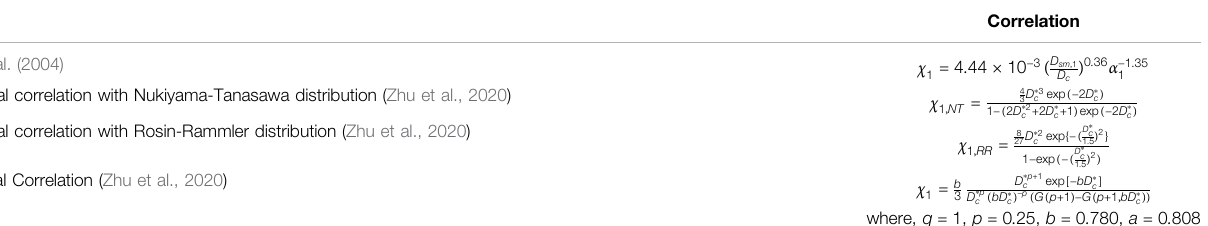
TABLE 1 | Correlations for the group-1 intergroup mass transfer coef fi cient. Model Correlation